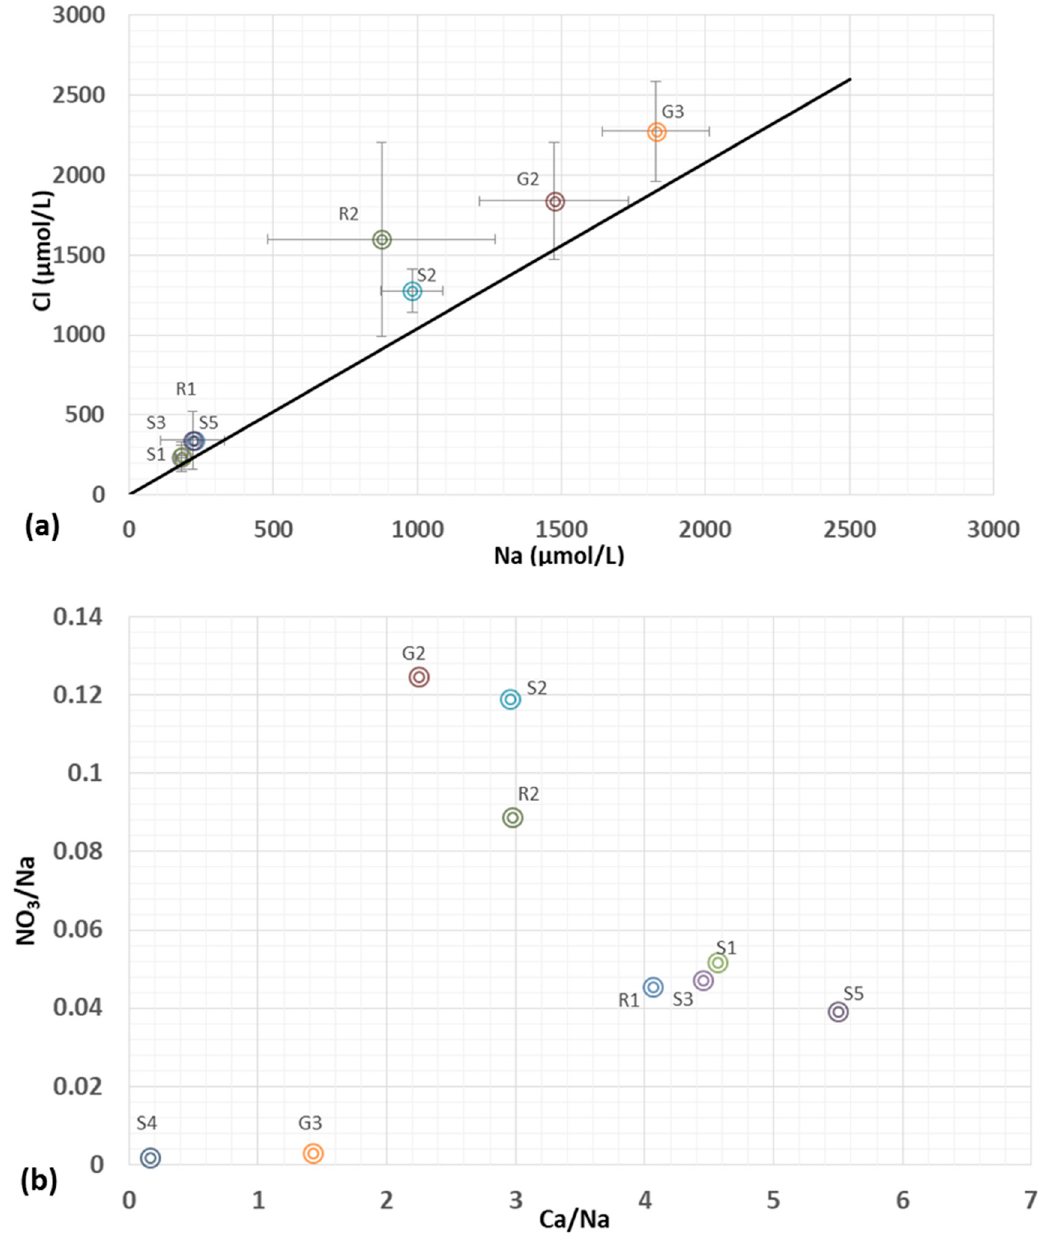
Figure 7. ( a ) Average Na vs. Cl concentration in the different water samples in Koiliaris CZO. The black line represents the Na/Cl ratio (1:1.04) from Finokalia Station. Error bars correspond to the standard deviation of the data. ( b ) Comparison between Ca/Na and NO 3 /Na ratios.